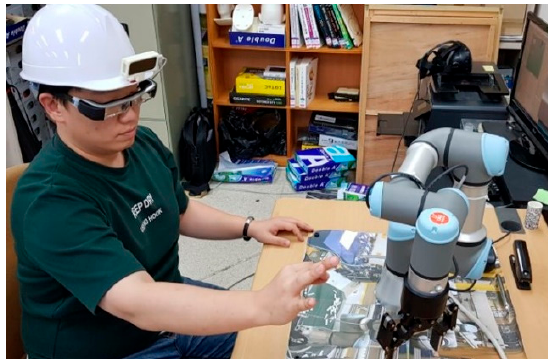
Figure 11. A worker was performing an experimental task.